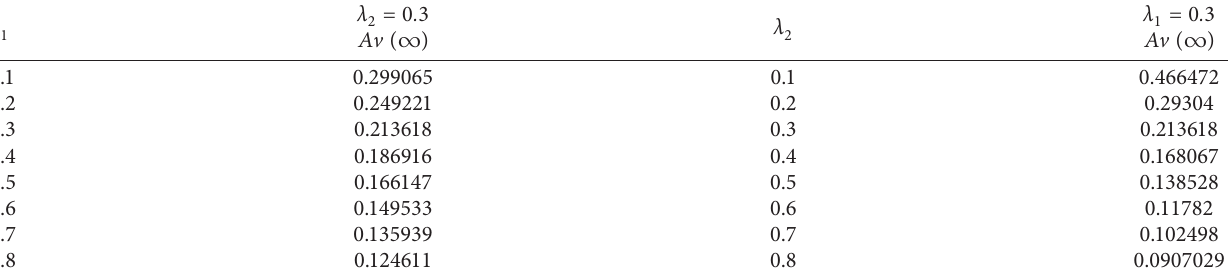
� 0 . 4 , β � 0 . 6 , η � 0 . 4 , θ 1 2